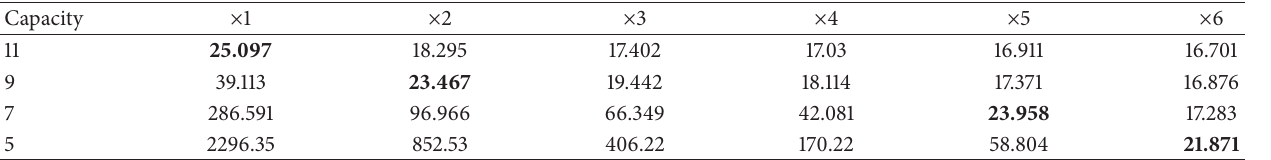
Table 2: Impact of substation and DG capacity.